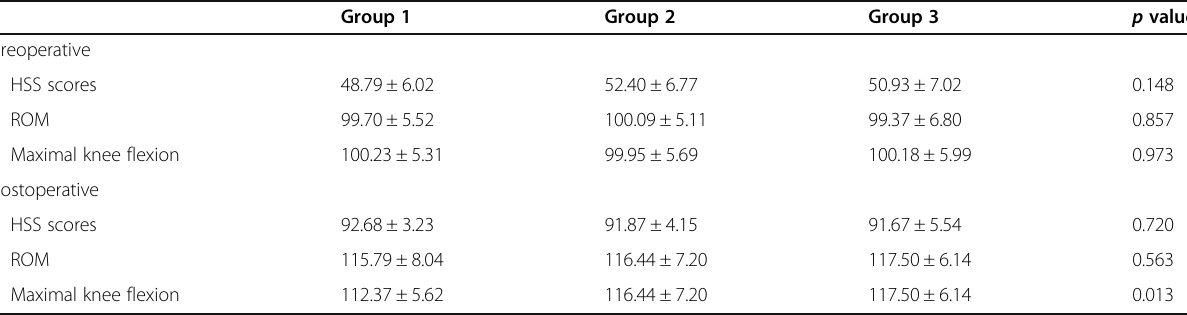
Table 2 The perioperative knee function in the three groups